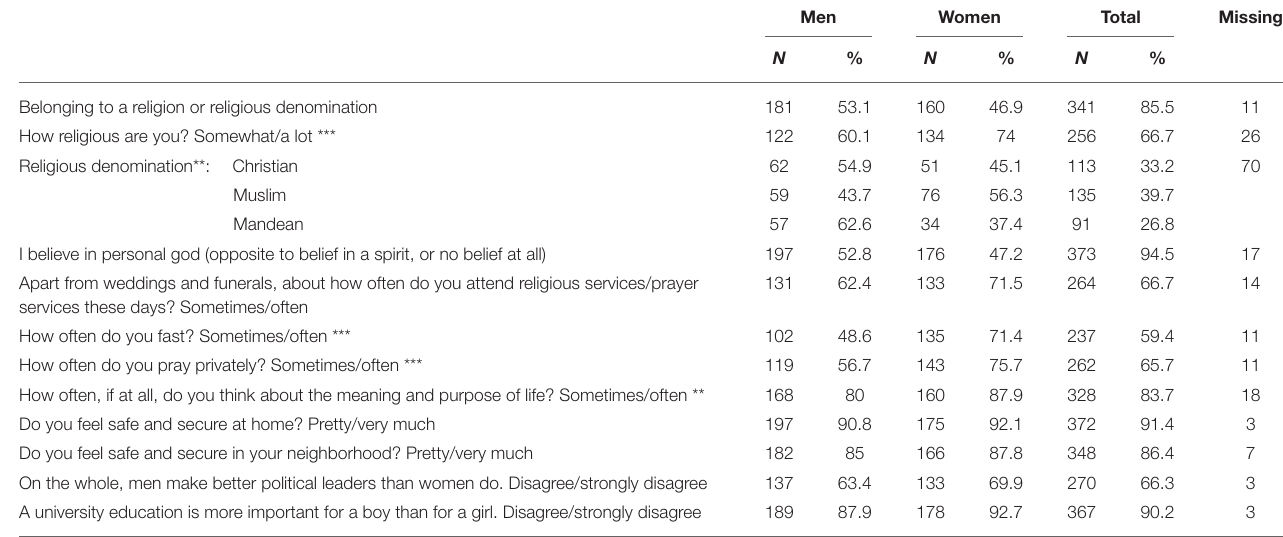
TABLE 5 | Frequency and percentage for religiosity, meaning, safety, and gender equality, by gender ( N = 410).